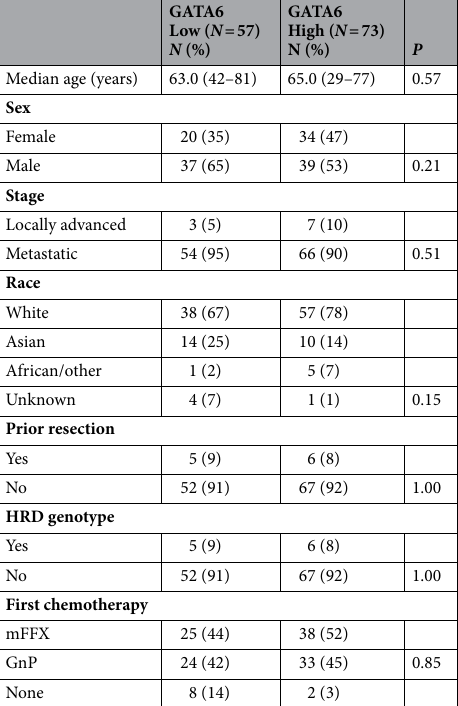
GATA6 High ( N = 73) N